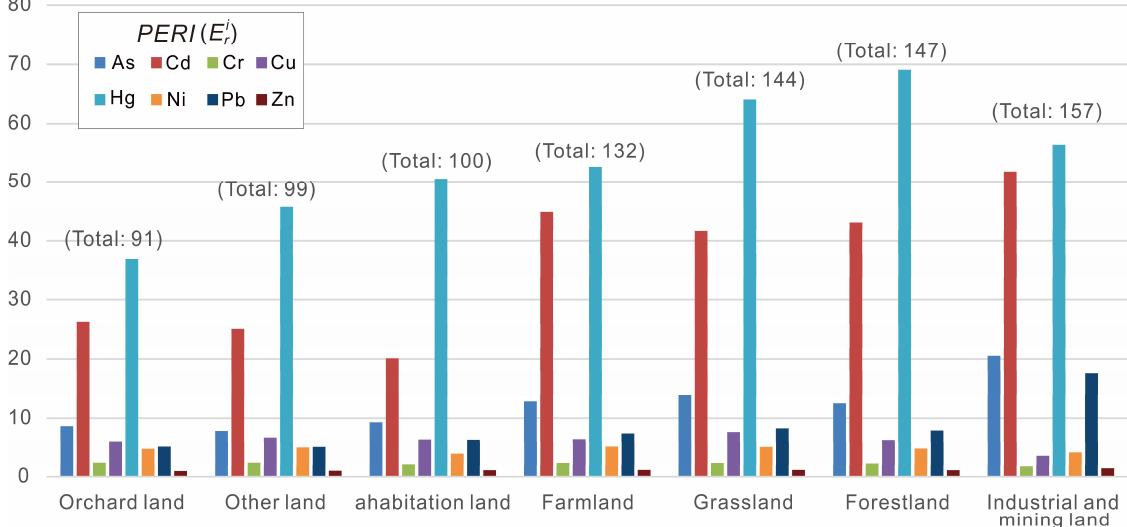
Figure 5. Average ecological risk index ( ) of heavy metals in different land uses.